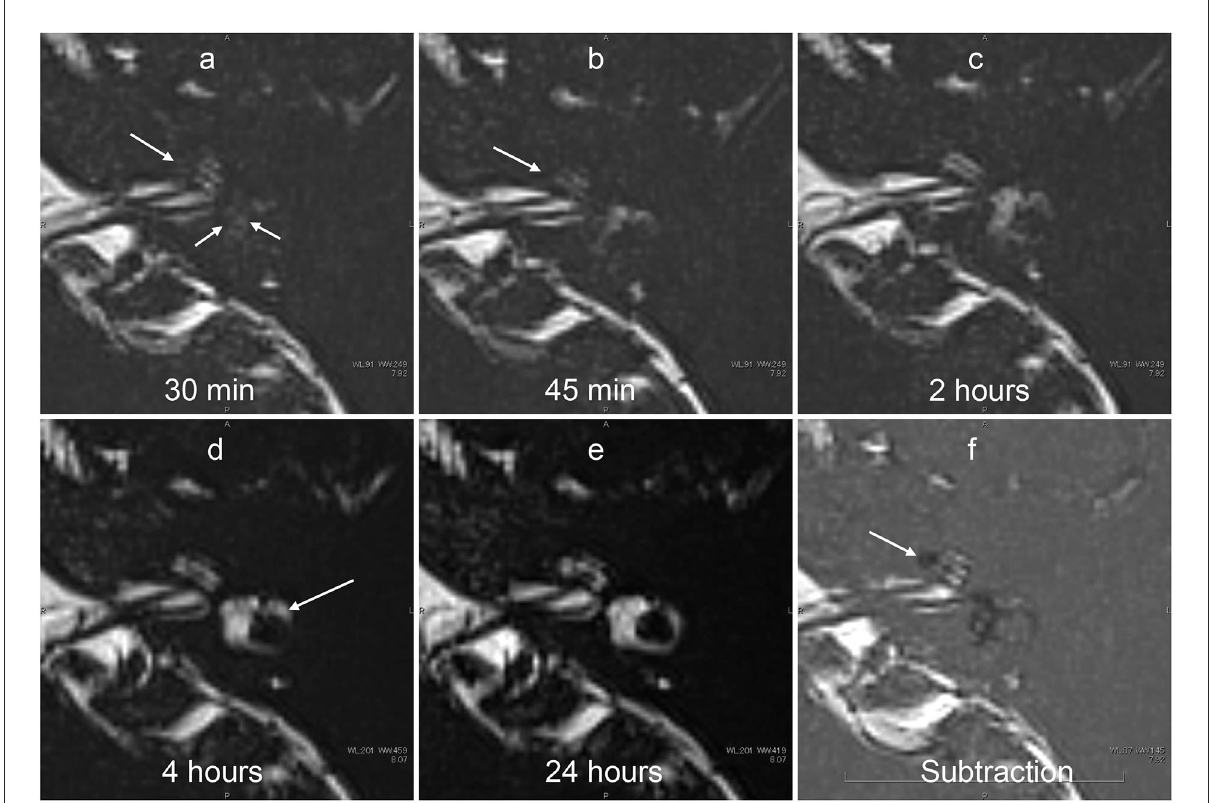
FIGURE7 Serial MR cisternography (TE: 3,200ms) of the left ear in a 34-year-old male volunteer (different volunteer from that shown in Figure 3) at 30min (a) , 45min (b) , 2h (c) , 4h (d) , and 24h (e) after intratympanic administration of 17 O-labeled saline. The subtraction image is also shown (f) . This subtraction image was generated as the value for (b) minus the value for a TE of 540s × 0.18. The MR scan was initiated ∼ 30min after the intratympanic administration of 17 O-labeled saline to the left middle ear. The images at the level of the cochlear nerve are shown. The signal decrease in the vestibule (short arrows in a ) and in the anterior part of the basal cochlear turn (arrows in a,b ) was most prominent in the image obtained at 30min. At 45min (c) , some parts of the cochlear (arrow) and the vestibular signal began to recover. At 2h, the vestibular signal and the signal in the basal turn of the cochlea recovered further (c) . At 4h, the signal for the lateral semicircular canal had recovered (arrows in d ). At 24h (e) , the signal for the left labyrinthine fluid had recovered to a level similar to that for the contralateral side (not shown). In the subtraction image (f) , an area with a rich distribution of 17 O-labeled water was seen as a lower signal area (arrow). This subtraction image provided an overview of the distribution of 17 O-labeled water and the anatomy of the labyrinth simultaneously in a single